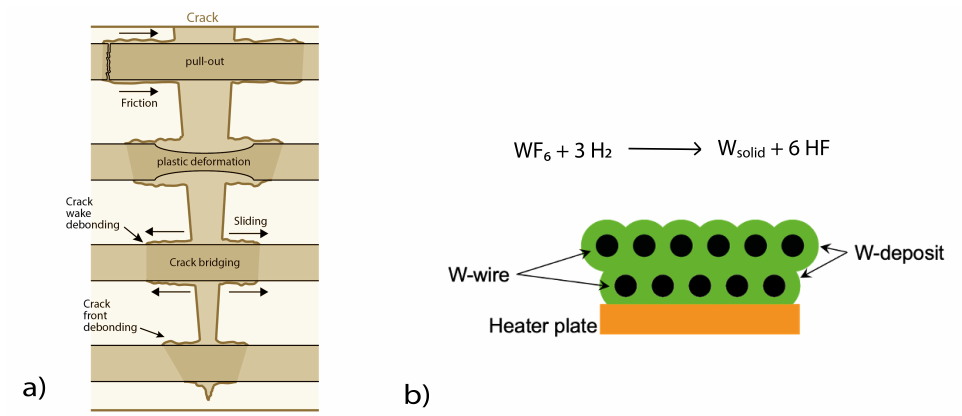
Figure 2. ( a ) A selection of energy-dissipation mechanisms in a fibre-composite material. Pull-out of fibres, pull-out of matrix elements, crack deflection at the interface, crack bridging by fibres, crack meandering at the interface, and plastic deformation of fibres (based on [8,36]). ( b ) Process of layer-wise growth of W f / W by applying one layer of weave at a